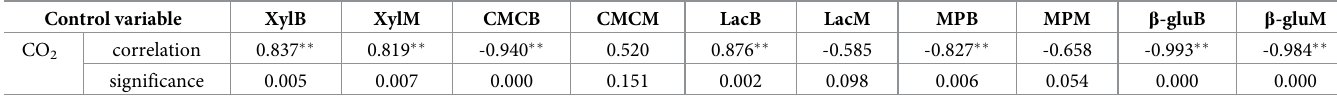
Table 2. The result on correlation analysis of CO 2 and five enzymes.